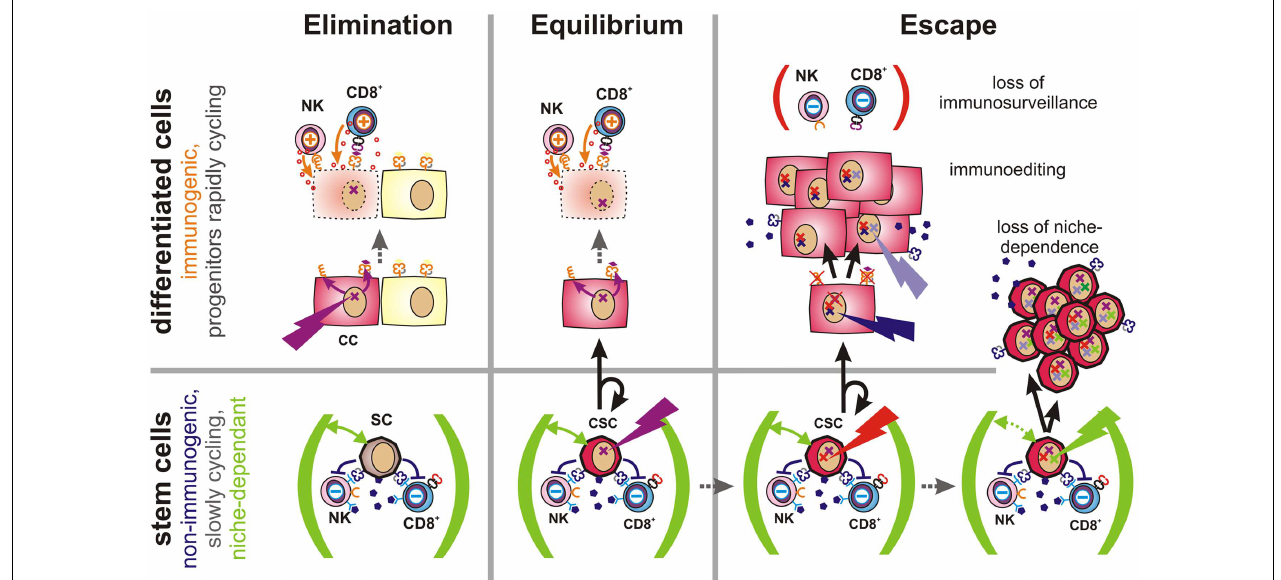
more immunogenic and could thus be eliminated by the adaptive immune system.Thus, a robust equilibrium may emerge. Escape (Right): immune system may lose its ability to constrain tumors due to aging, immunosuppressive therapies, diseases or other factors. Immunoediting describes the evolutionary adaptation of individual tumor subclones to the selection pressure exerted by the immune system. It will ultimately lead to expansion of less-immunogenic or more immunosuppressive subclones. Non-immunogenic CSCs may further acquire the ability to expand independently of their niches, which may lead to the outgrowth of poorly differentiated